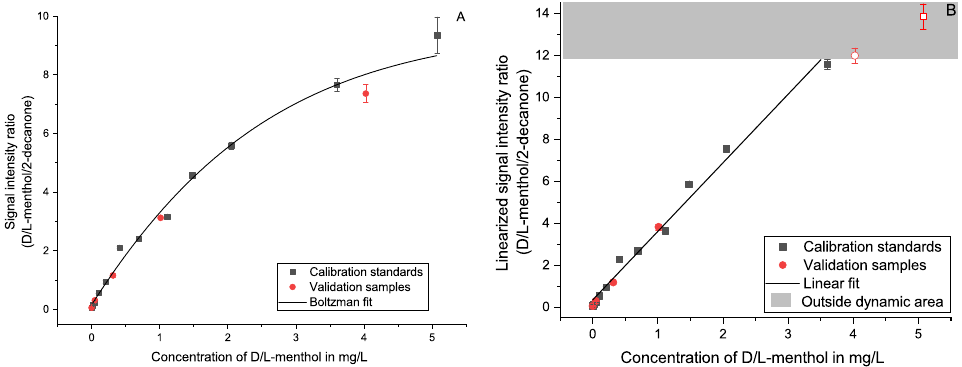
Figure 8. Calibration regression for Menthol (D- and L-isomers) using 0.1 mg/L 2-decanone as an internal standard in matrix; based on a Boltzmann function ( A ) and a linearly converted function ( B ). The area outside the usable dynamic range is colored gray, and the data points are colored light red and are unfilled to illustrate that they are not included in the calculated